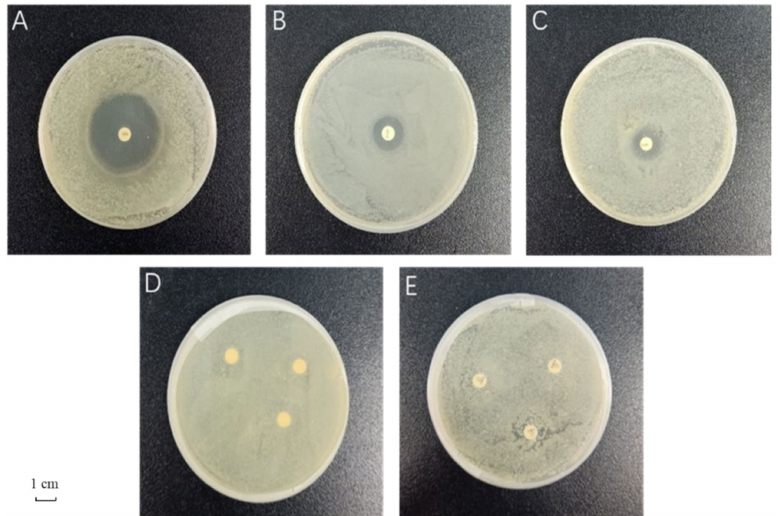
Figure 1. Bacteriostatic effect of five antibiotics on gut bacteria of Grapholita molesta . ( A ) ciprofloxacin; ( B ) streptomycin; ( C ) chloramphenicol; ( D ) rifampicin; ( E ) ampicillin. Table 1. Inhibition zone diameters of five antibiotics on the growth of culturable gut microbiota of Grapholita molesta at MH agar